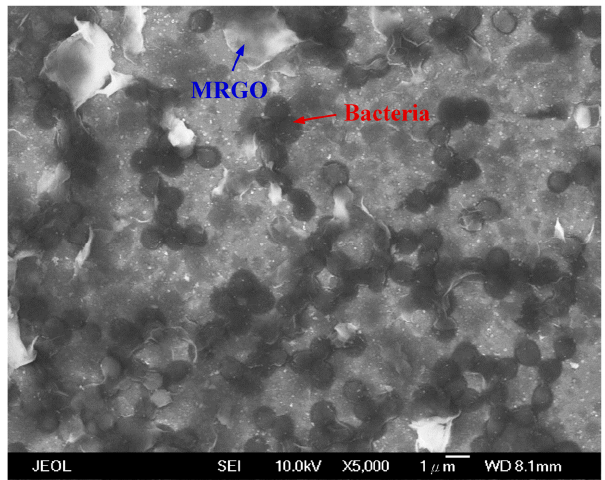
Figure 6. SEM image of MRGO sheets capturing bacteria (S. aureus) (scale bar: 1 μ m).